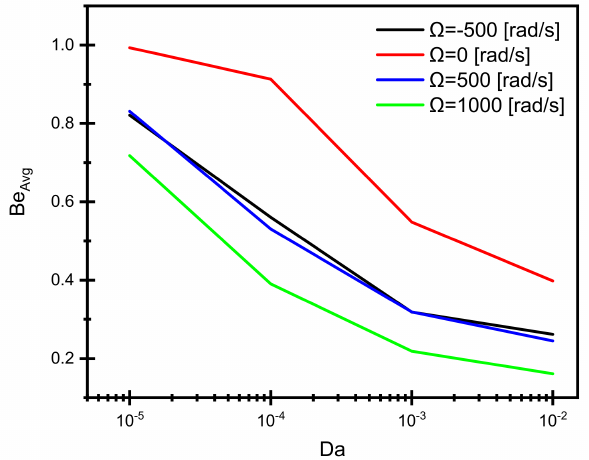
Figure 10. Effect of the Darcy number on the average Bejan number at different values and directions of the cylinder